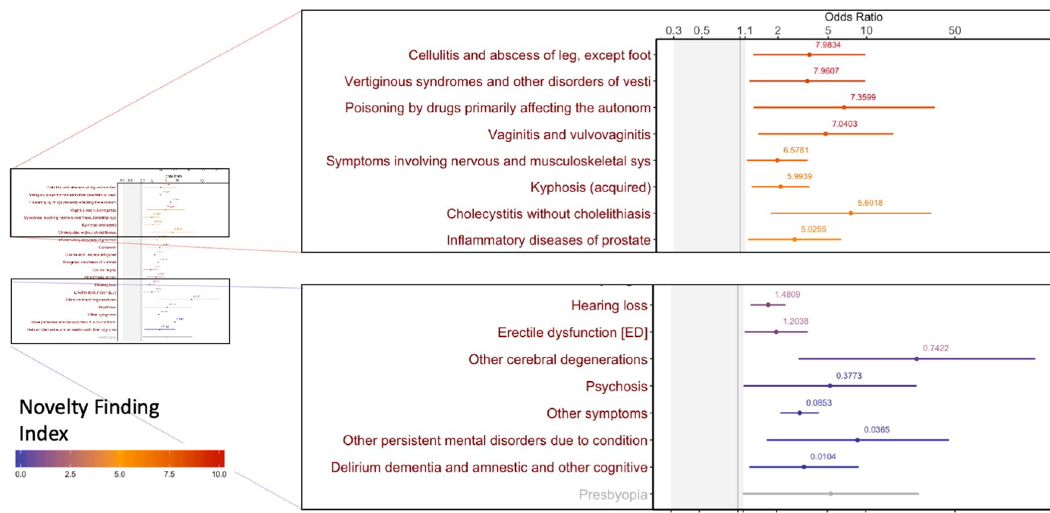
Fig 4. Significant associations 0–5 years before a diagnosis of Alzheimer’s disease presented as an odds ratio plot. Each dot represents the point estimate of the odds ratio computed from a logistic regression and the line indicates its 95% confidence interval. Each condition is color coded by its novelty finding index, the value of which is displayed above the confidence interval.